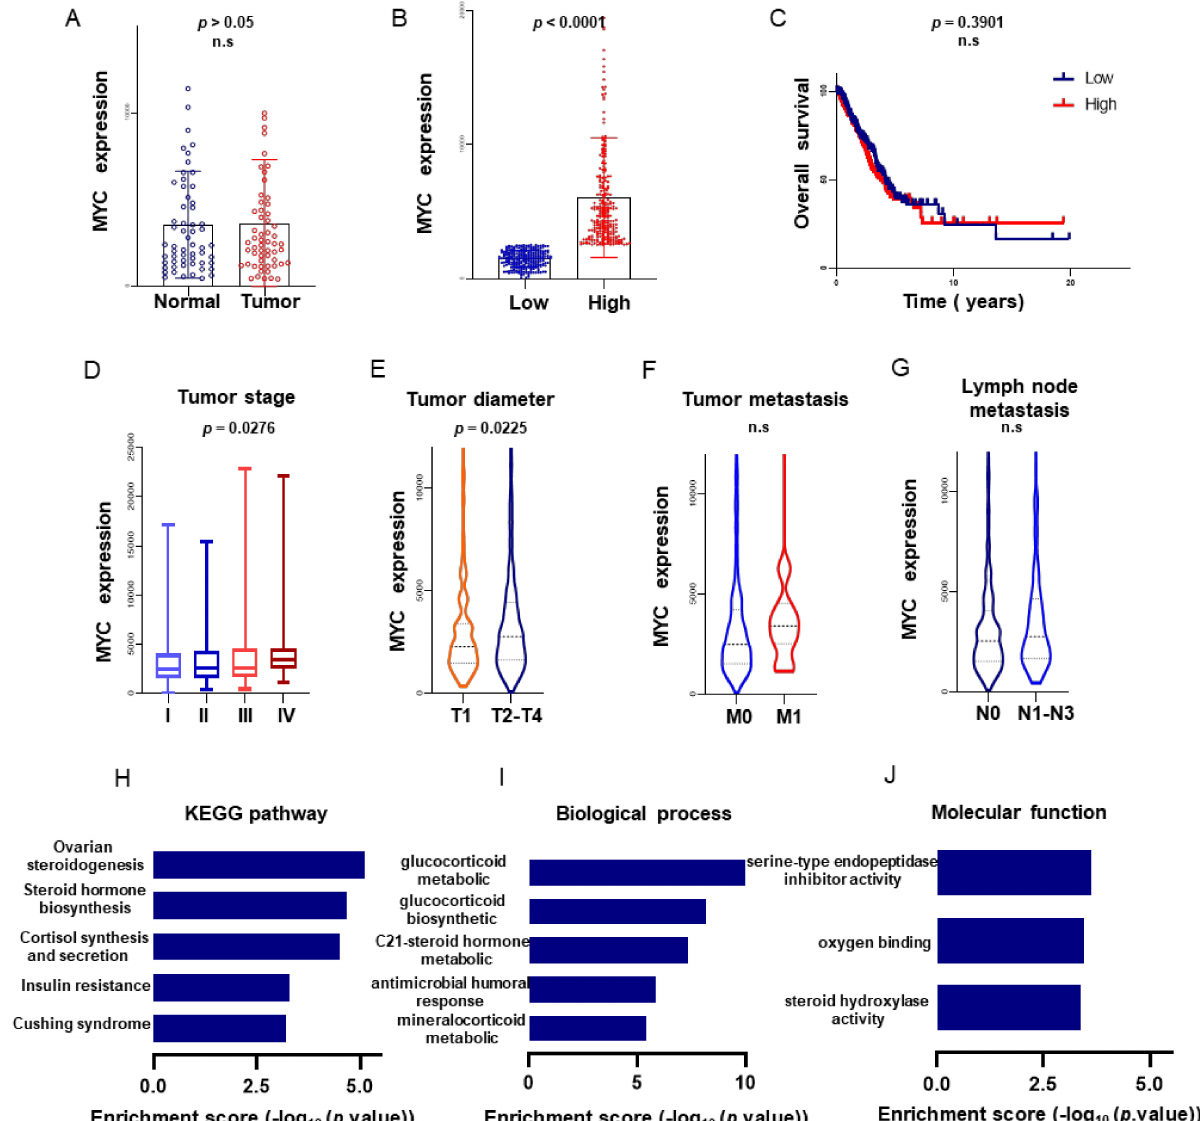
Figure 1. Expression of MYC in lung adenocarcinoma (LUAD). There was no significant difference in MYC expression in LUAD tissues and adjacent tissues ( A ). According to the MYC expression level, patients with LUAD were divided into high expression levels and low expression levels ( B ). There was no significant difference between the MYC expression level and patient survival time ( C ). The MYC expression level was associated with tumor stage, lymph node metastasis, tumor metastasis, and tumor diameter ( D – G ). The Kyoto Encyclopedia of Genes and Genomes (KEGG) analysis and gene ontology (GO) analysis of differentially expressed genes related to MYC ( H – J